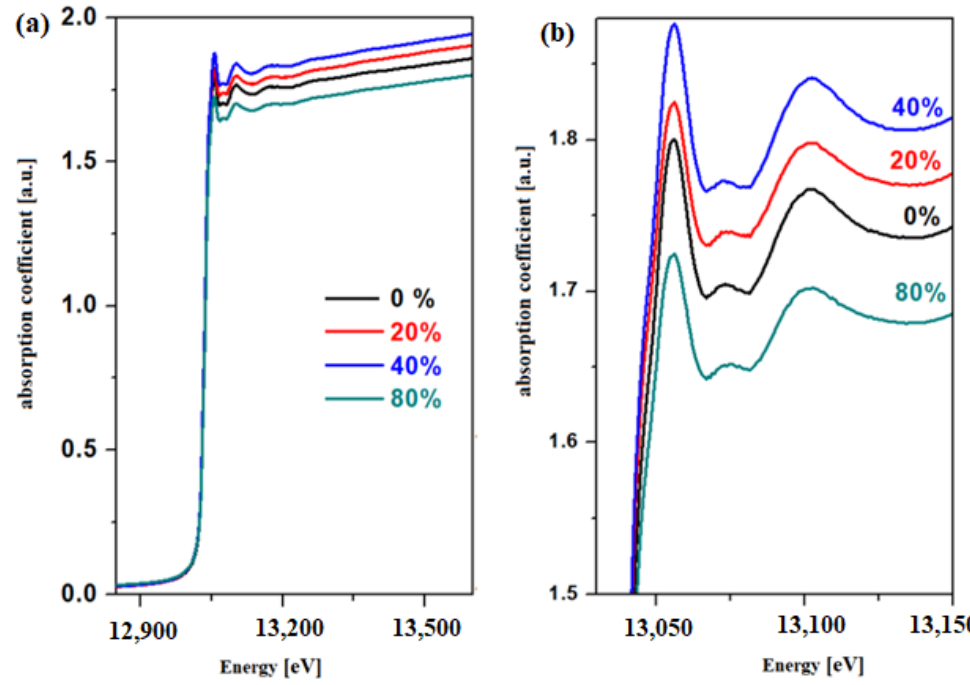
Figure 2. XANES spectra for the L3 edge of the lead atom for the vitroceramic system with chemical formula 15MnO 2 · 85[(100 − x)PbO 2 · xPb] where x = 0–80 mol% Pb in the region between ( a ) 12,825 and 13,575 eV ( b ) 13,025 and 13,150 eV.